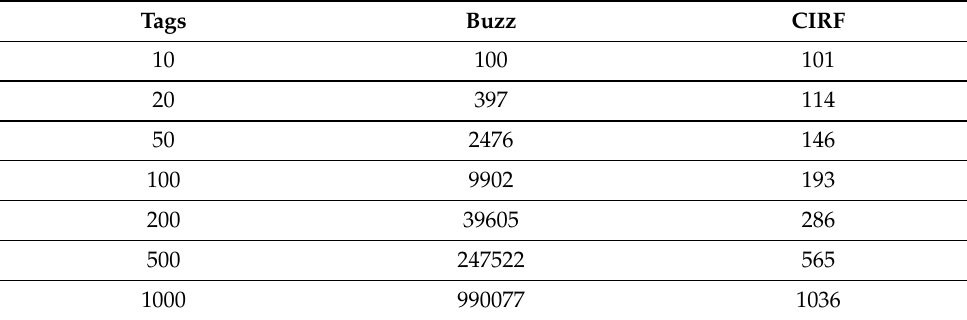
Table 2. Number of columns in